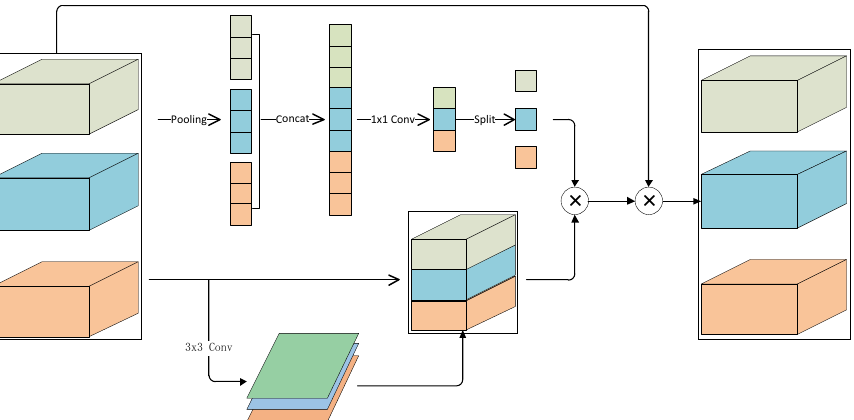
Figure 3. Multi-layer channel and spatial attention (MLCS) module. MLCS consists of two parallel branches. The first branch is used to learn the weights of each feature layer in order to tell which feature layer is optimal for identifying objects. The second branch is mainly used to learn a spatial position weight for each feature